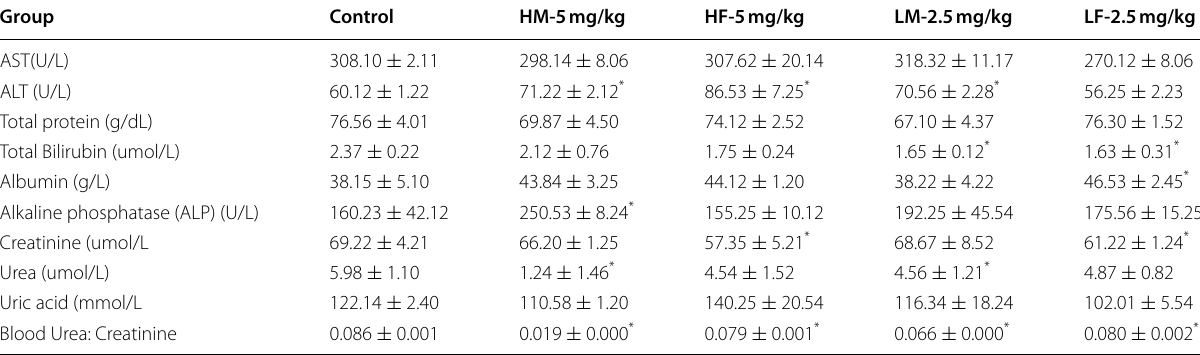
Table 3 Sub-chronic toxicity study from the plasma using AST, ALT, Total protein, bilirubin, albumin, ALP, creatinine, urea and uric acid in male and female rats treated at 2.5 mg/kg and 5 mg/kg dose of Mystomate4 ® compared with control administered the vehicle